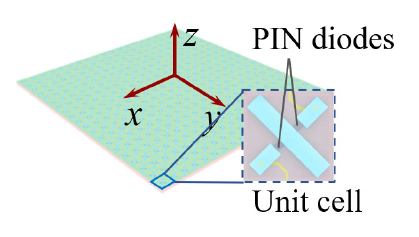
Figure 2. Proposed structure of APCM unit cell. ( a ) The APCM unit cell consists of 30 × 30-unit cells . ( b ) 3D schematic of the unit cell.